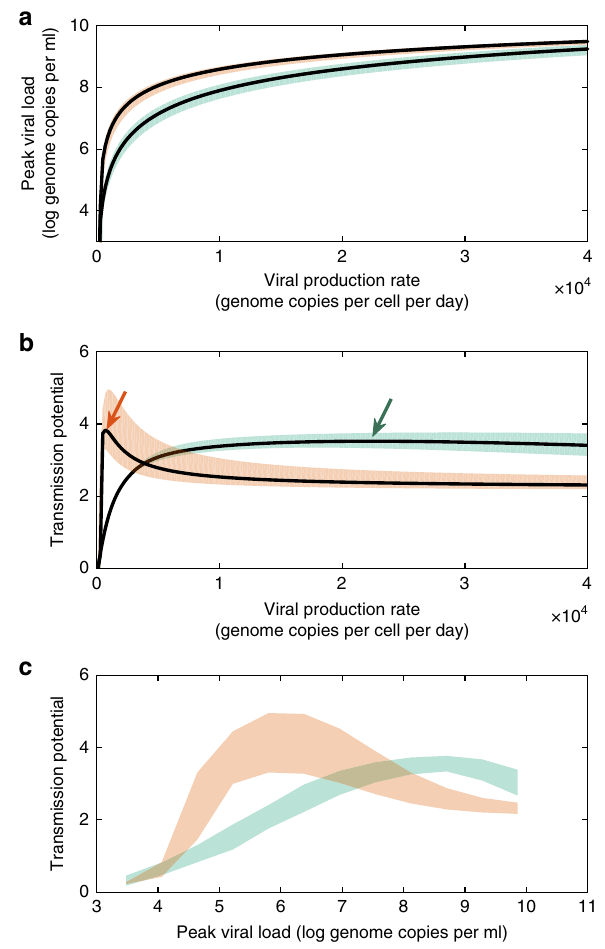
Fig. 3 Model-predicted virulence trade-offs for dengue virus. a Model- predicted relationship between the dengue virus production rate and peak viral load, a strong predictor for the risk of developing severe dengue disease. b Model-predicted relationship between the dengue virus production rate and dengue ’ s transmission potential. Green and orange arrows point to the peaks in transmission potential for primary and secondary infections, respectively. c Model-predicted relationship between peak viral load and dengue ’ s transmission potential. In a – c , shaded regions show uncertainty estimates, derived from variation in the viral infectivity rate (Methods). Primary infections are shown in green and